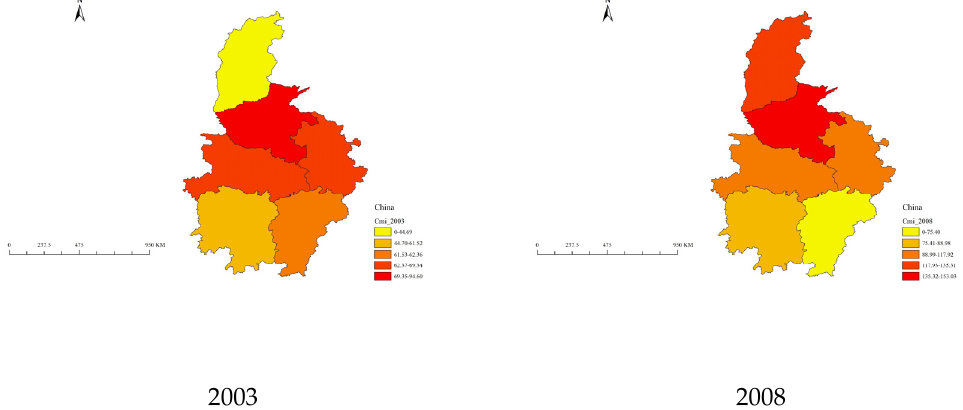
2019 Figure 2. The level of market integration in eastern China. The central region always showing an upward trend and maintaining a leading po- sition until 2009 in Figure 3, which may also be closely related to the strategic develop- ment of the rise of central China that the Chinese government has advocated. The level of market integration in the western region has always been on the rise in Figure 4, showing a slower growth between 2003 and 2012, but between 2012 and 2016, the level of market integration in the western region achieved a significant increase, which